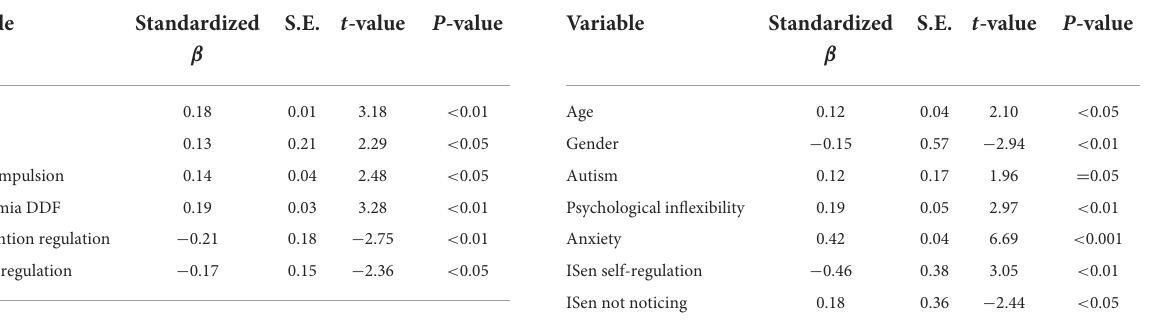
TABLE 5 Regression model summary where autism is the DV. TABLE 6 Regression model summary where OCD is the DV.